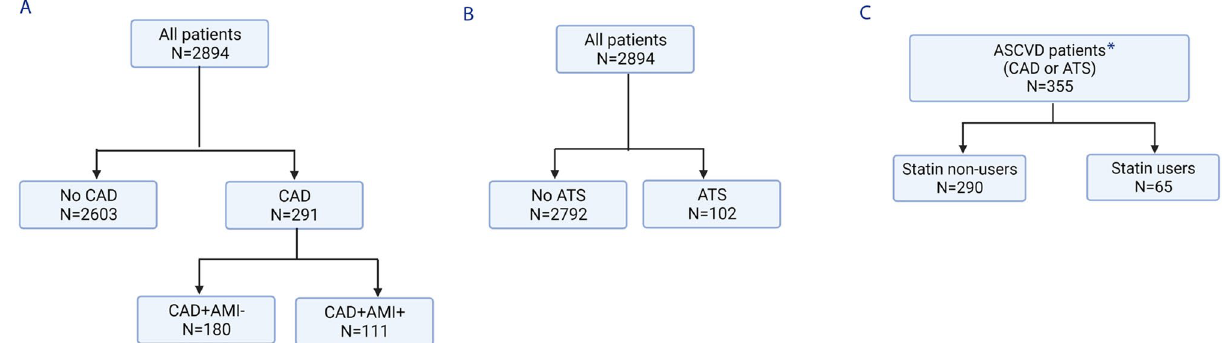
Figure 1. Flow diagram for patient stratification. ( A ) Stratification based on the diagnosis of pre-existing coronary artery disease (CAD). ( B ) Stratification based on the diagnosis of pre-existing atherothrombotic stroke (ATS). ( C ) Stratification based on statin use among patients with Atherosclerotic cardiovascular disease (ASCVD). CAD + AMI − , Pre-existing coronary artery disease without prior acute myocardial infarction; CAD + AMI + , Pre-existing coronary artery disease with prior acute myocardial infarction. * 38 patients had both pre-existing CAD and